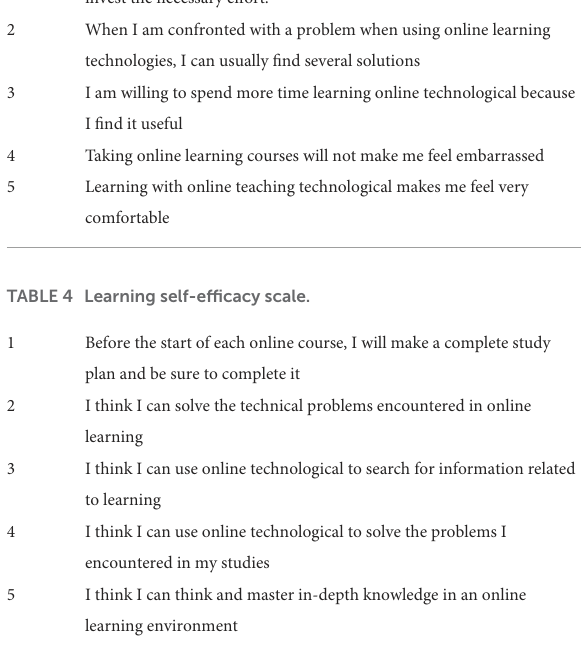
TABLE 6 Deep learning